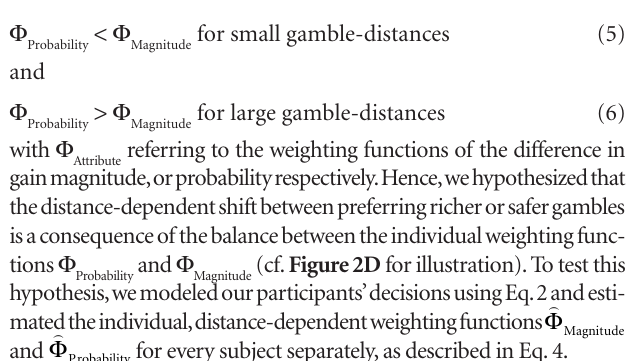
Figure 5 | relation of CDD-related activations to individual intransitivity indices. Activations in brain regions covarying with CDD values and individual intransitivity scores in (A) DLPFC (peak at − 45, 24, 33), (B) bilateral striatum